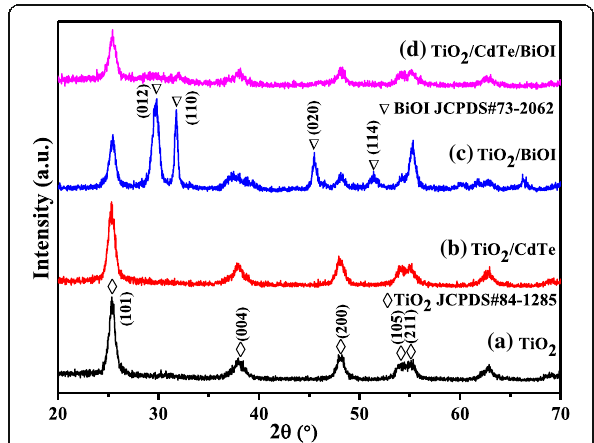
Fig. 1 XRD patterns of a bare TiO 2 , b TiO 2 /CdTe, c TiO 2 /BiOI, and d TiO 2 /CdTe/BiOI